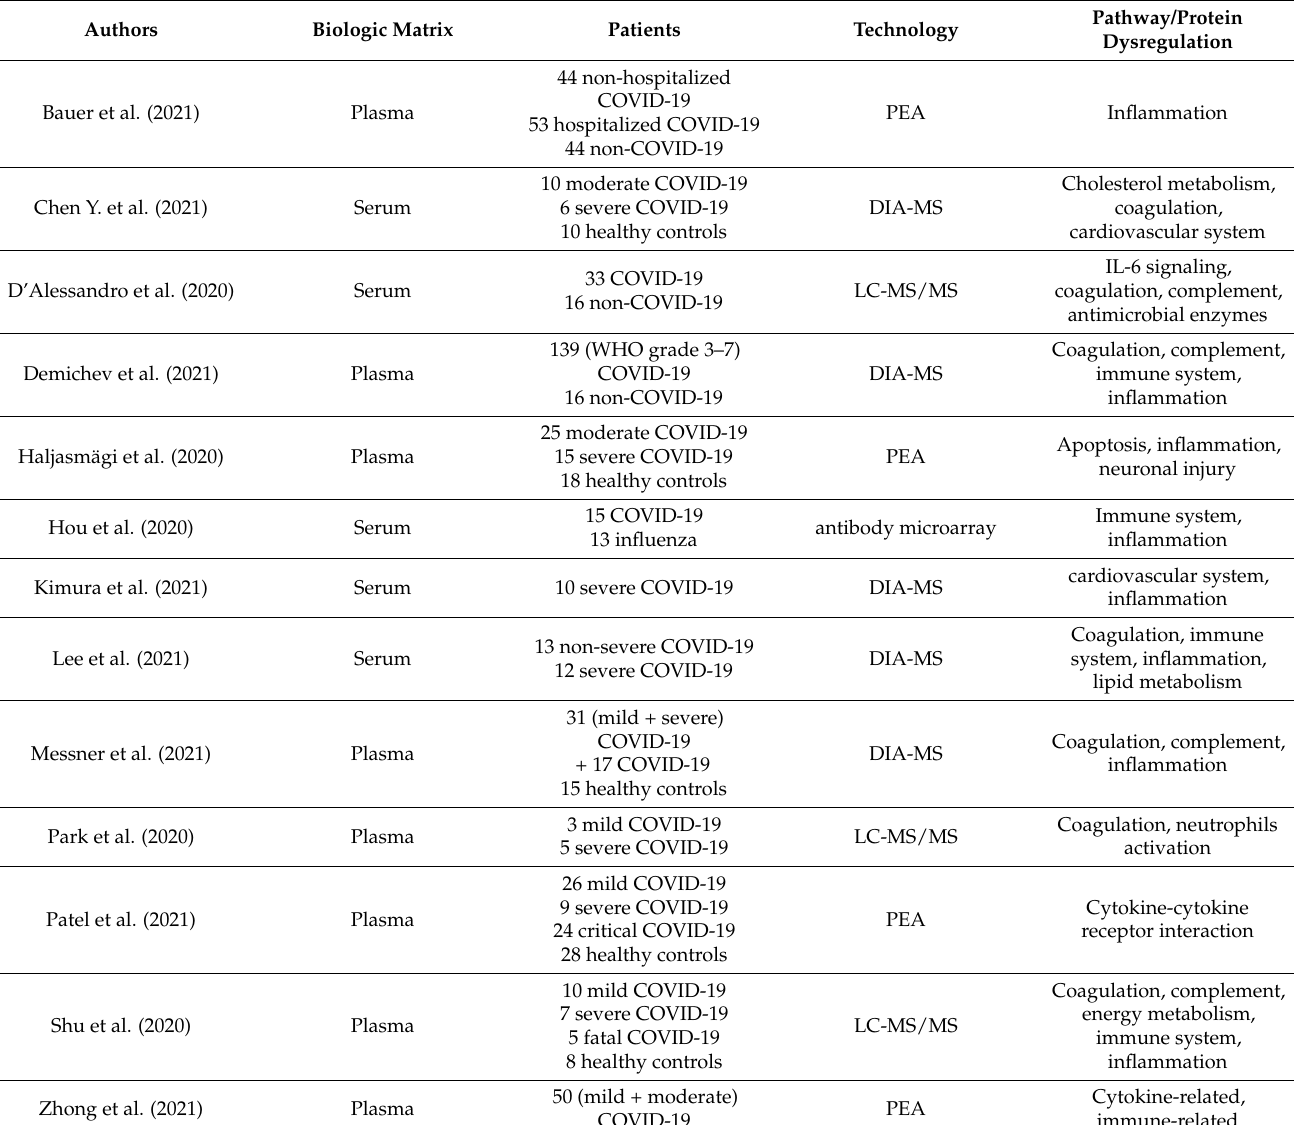
Table 1. Summary of the main characteristics of the proteomics publications related to COVID- 19